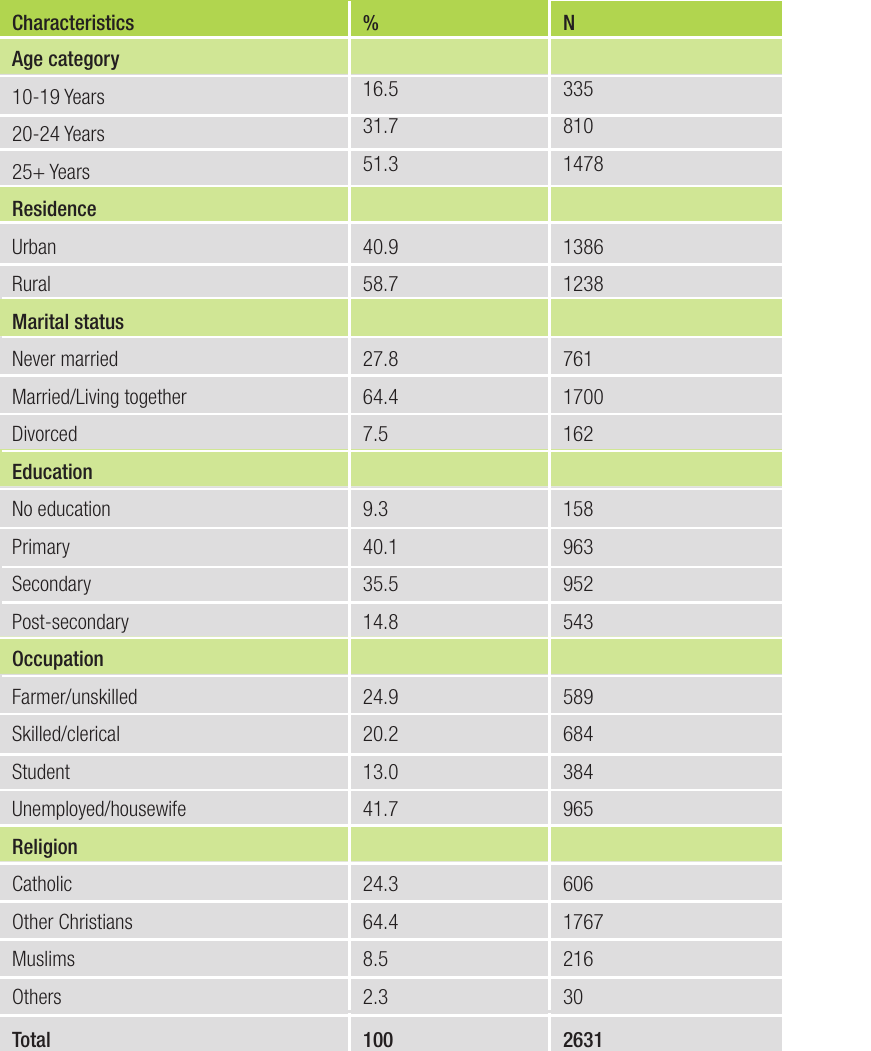
Table shows weighted proportions and un-weighted counts. All variables missing <1% of data.